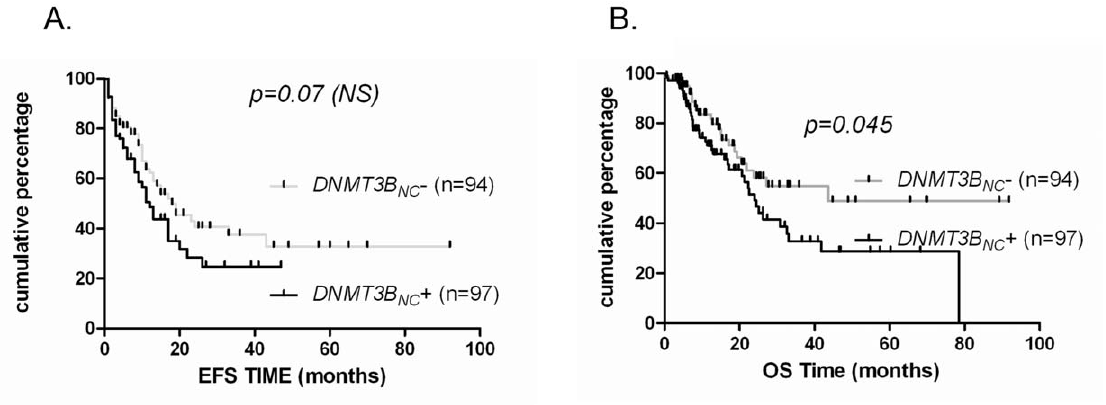
Figure 7. High DNMT 3B NC expression associates with poor survival outcome. Kaplan-Meier analysis of two groups with expression levels above or below the cut-off as described in method section for DNMT3B NC . EFS (A) and OS (B) were assessed in 191 patients.